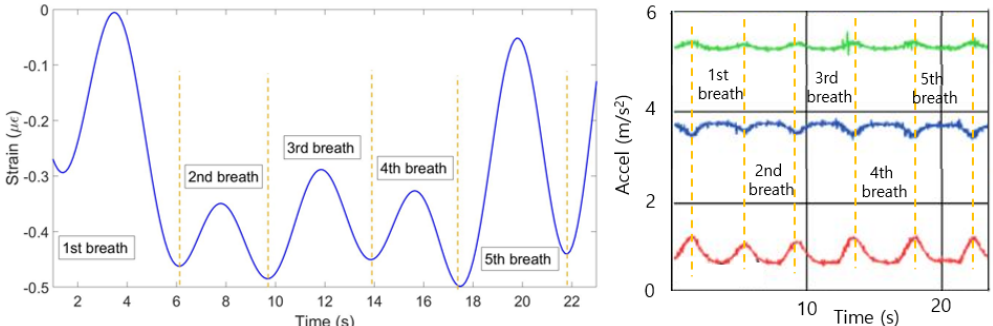
Figure 11. Breathing pattern for the first volunteer in the staying position reconstructed based on the 10 FBGs strain patterns ( left ) and obtained from the reference sensor ( right